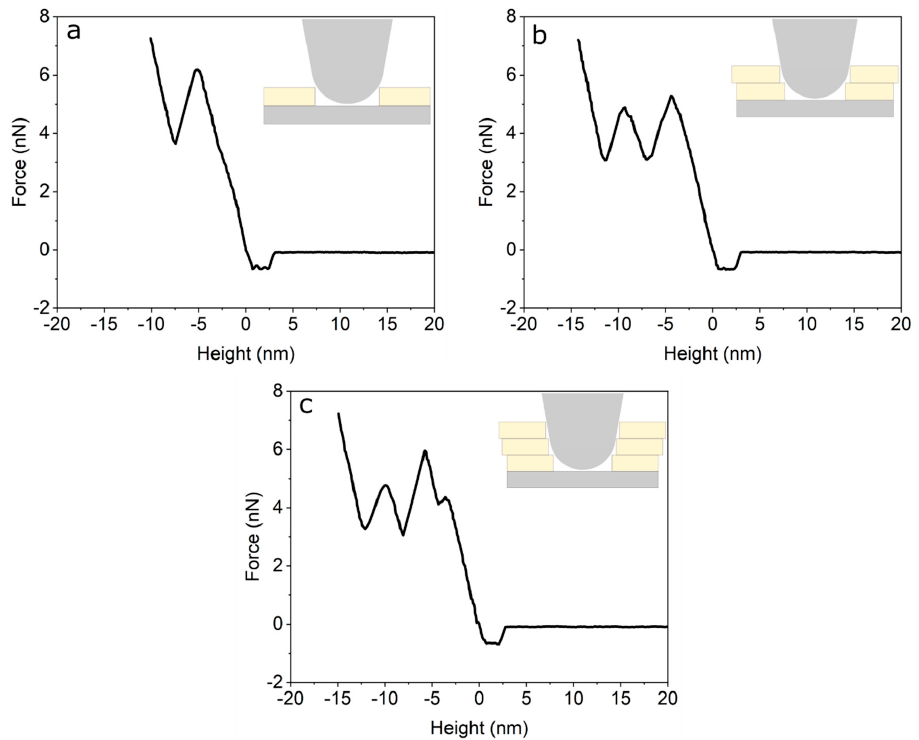
Figure 2. ( a ) Force curve on the first bilayer (level 1). ( b ) Force curve on the second bilayer (level 2). ( c ) Force curve on the third bilayer (level 3). ( c ) Force curve on the third bilayer (level